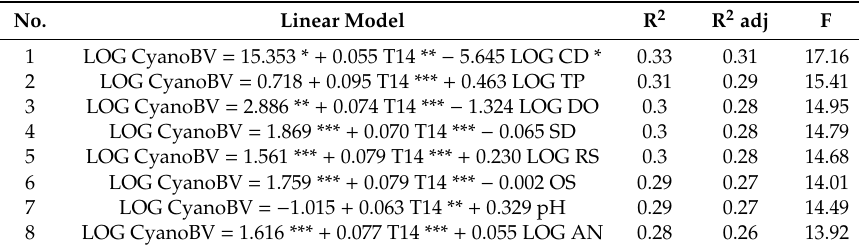
Table A2. Two-variable multiple linear regression (MLR) models of cyanobacteria biovolume (LOG CyanoBV) using the 14-days mean atmospheric temperature (T14) and one of the physical–chemical variables (AN: Ammonium nitrogen; CD: Conductivity; TP: Total phosphorous; SD: Secchi disk depth; RS: Reactive silicates; DO: Dissolved oxygen; OS: Saturation oxygen percentage; and pH). The statistical significance of each coe ffi cient is indicated when below 0.05 ( p -values: ***: 0.001; **: 0.01; *: 0.05). For each model the coe ffi cient of determination (R 2 ), the adjusted R 2 (R 2 adj), and the F statistic are reported. LOG means 10-based logarithm.